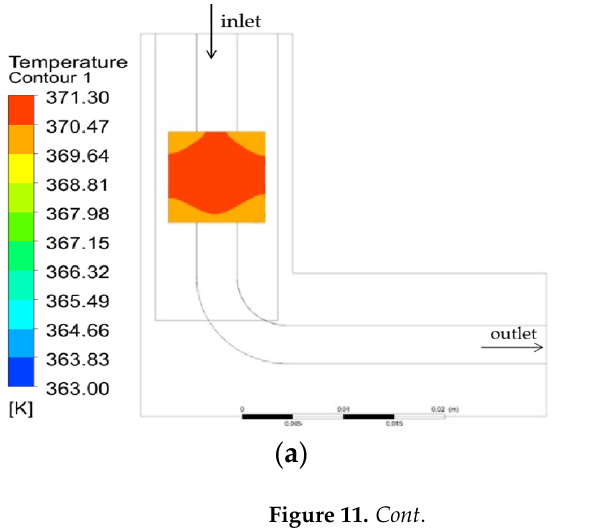
Table 5. Numerical results of di ff erent heat source positions.